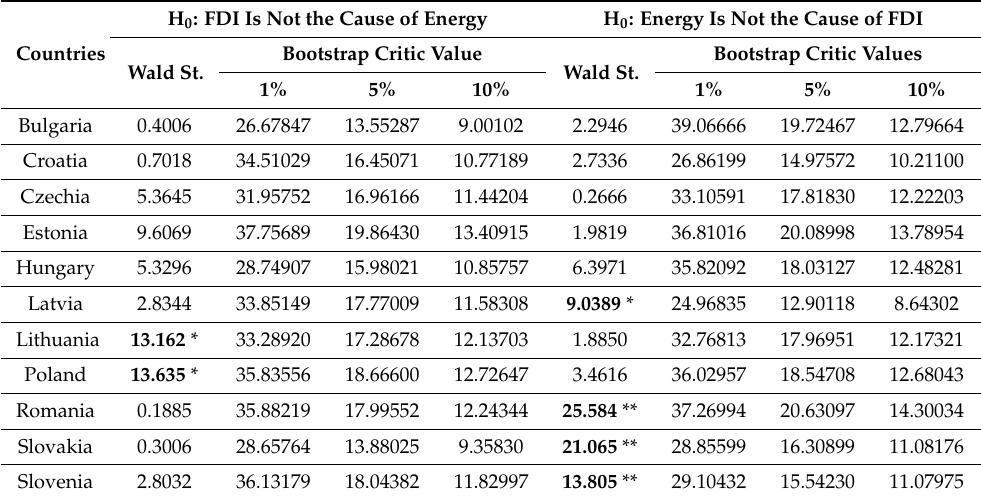
Table 8. Causality analysis between the financial development index and primary energy consumption.